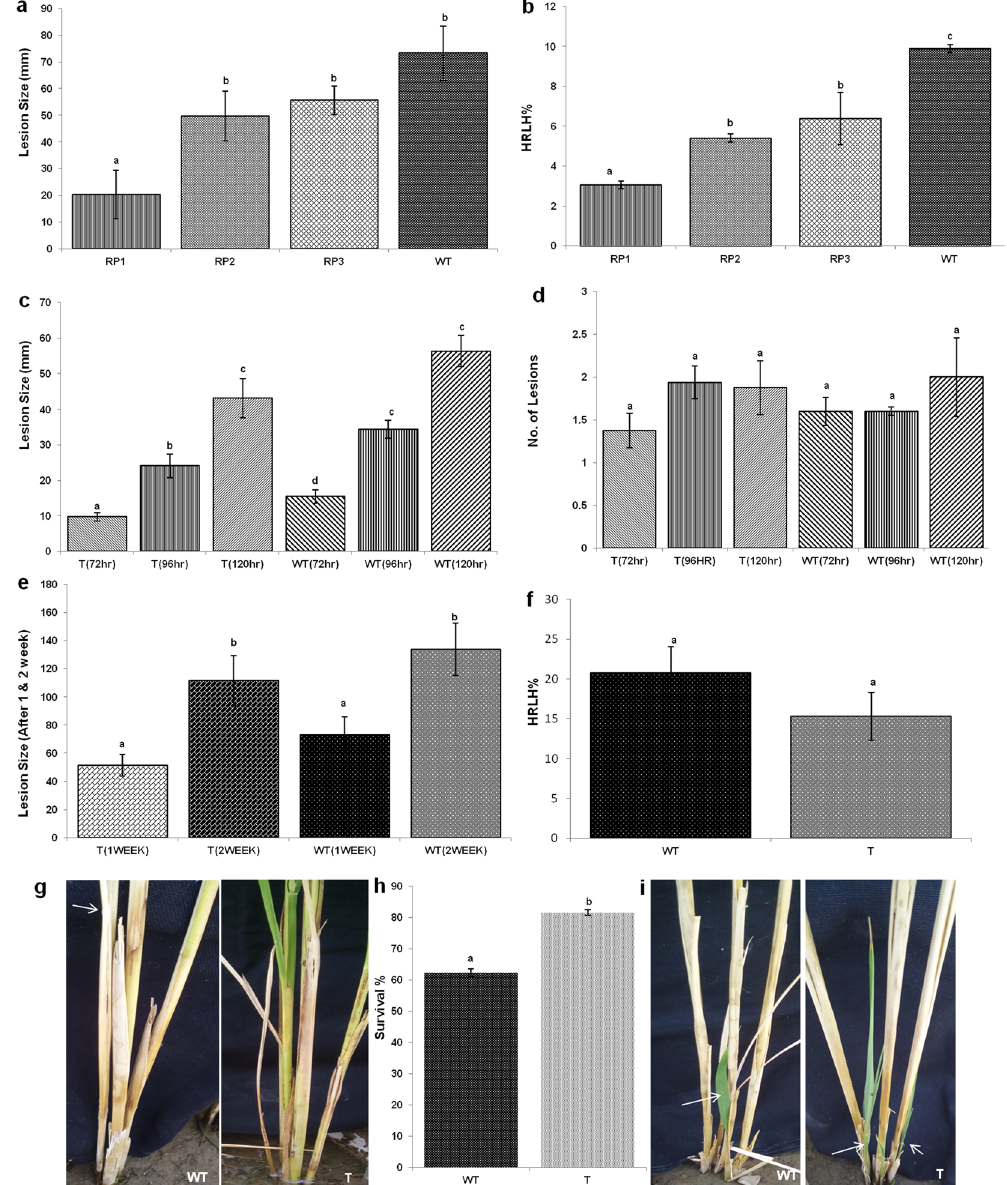
Figure 7. Disease progression and survival of transgenic and wild type control plants after R. solani infection. ( a ) Lesion size and ( b ) Highest Relative Lesion Height percentage (HRLH%) in T1 transgenic and non- transgenic controls. ( c ) Lesion size and ( d ) number of lesions in homozygous T2 plants from the RP1 transgenic line and non-transgenic controls at several times after infection. ( e ) Lesion size in homozygous T2 plants from the RP1 transgenic line and non-transgenic controls one and two weeks after inoculation. ( f ) HRLH% in homozygous T2 plants from the RP1 transgenic line and non-transgenic controls two weeks after inoculation. ( g ) Death of few tillers in wild type control as compared to transgenic plants after 2 weeks of infection; ( h ) Effect of R. solani infection on survival of tillers; ( i ) Emergence of new tillers was also reduced in wild type control as compared to transgenics after infection. Error bars indicate standard errors. (p = 0.05; ANOVA; with Tukey Kramer Multiple Comparison); WT = Non transgenic plants; T = Transgenic